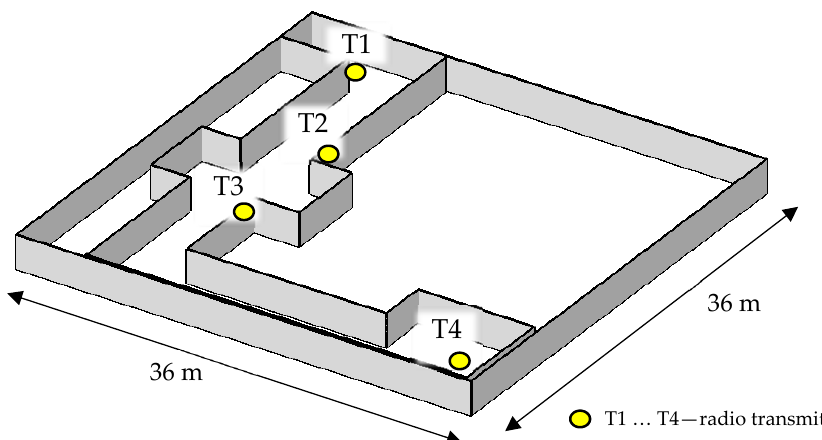
Figure 10. Indoor environment simulation model for the third verification scenario. Data from [41].